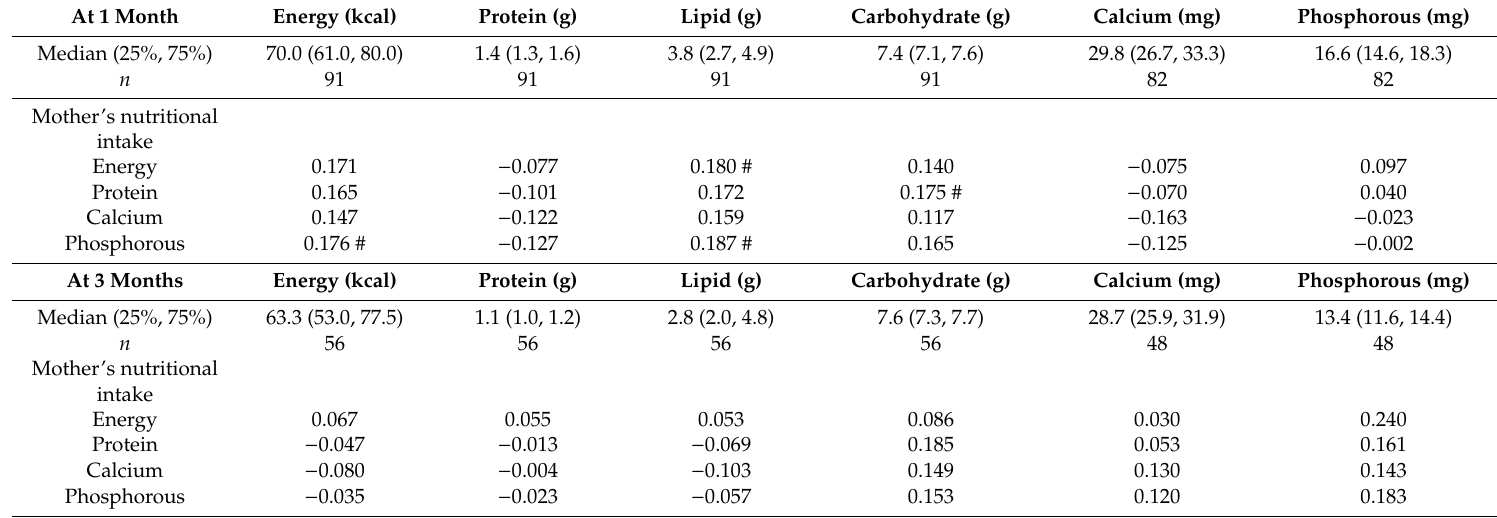
Table 4. Spearman’s correlation coe ffi cients of maternal nutritional intake and breast milk macronutrient content at 1 and 3 months after delivery. At 1